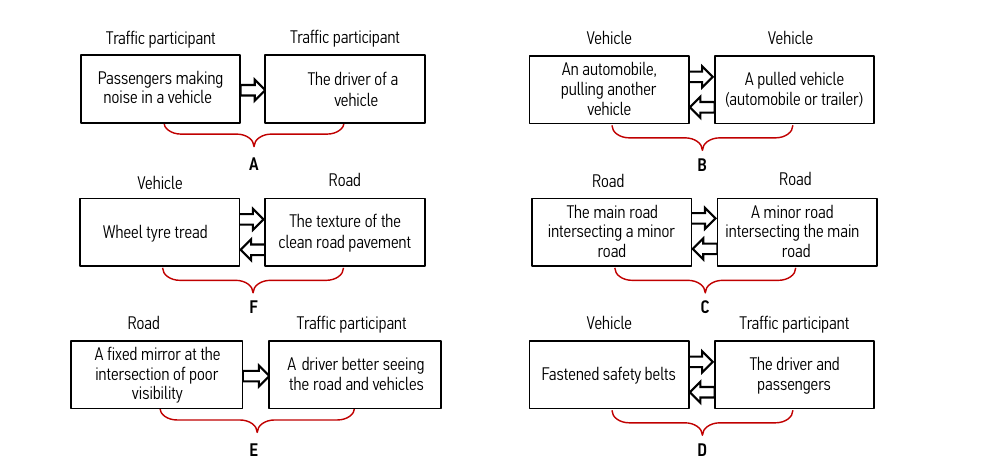
Fig. 1. The examples of a direct unilateral and bilateral interaction between the elements of the traffic